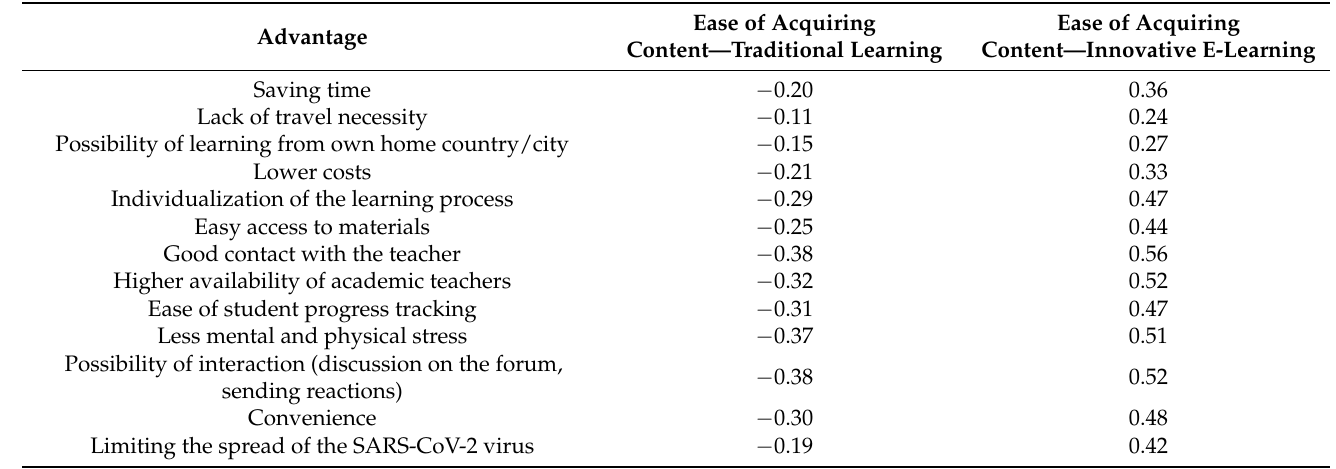
Table 4. Sperman’s rank correlations between the advantages of using innovative e-learning and the ease of acquiring content by students in traditional learning and e-learning.